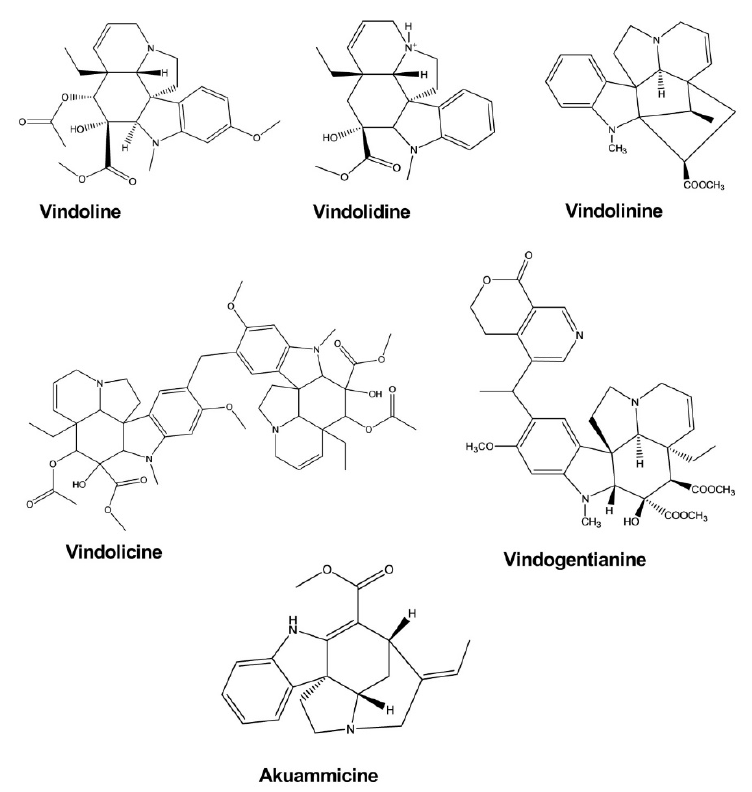
Figure 8. Antidiabetic activity of indole alkaloids.